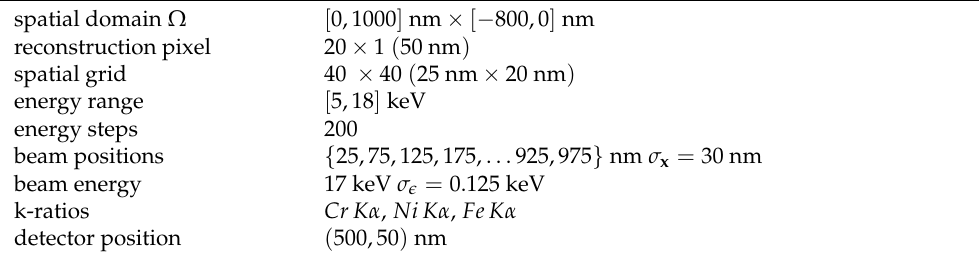
Table 3. Discretization and model parameters used for the reconstruction of a layered